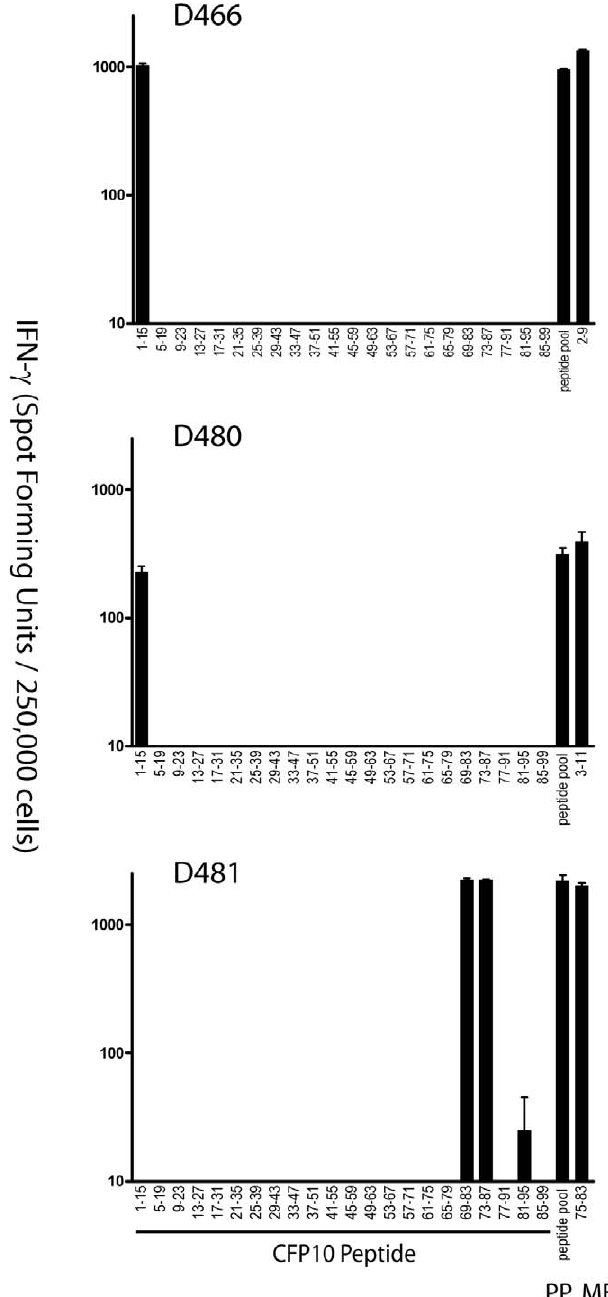
Figure 6. Profiling of Immunodominance Pattern for CFP10 To determine the effector cell frequencies, autologous DCs (20,000/well) were pulsed either with each individual 15-mer peptide (5 l g/ml), the peptide pool (PP; 5 l g/each peptide), or the minimal epitope (ME) determined from T cell clones derived from each donor (D466:CFP10 2–11 ; D480:CFP10 3–11 ; D481:CFP10 75–83 ; 5 l g/ml), and tested against 250,000 magnetic bead–purified CD8 þ T cells. IFN- c release was assessed by ELISPOT after 18 h of co-culture. Each point represents the mean of duplicate